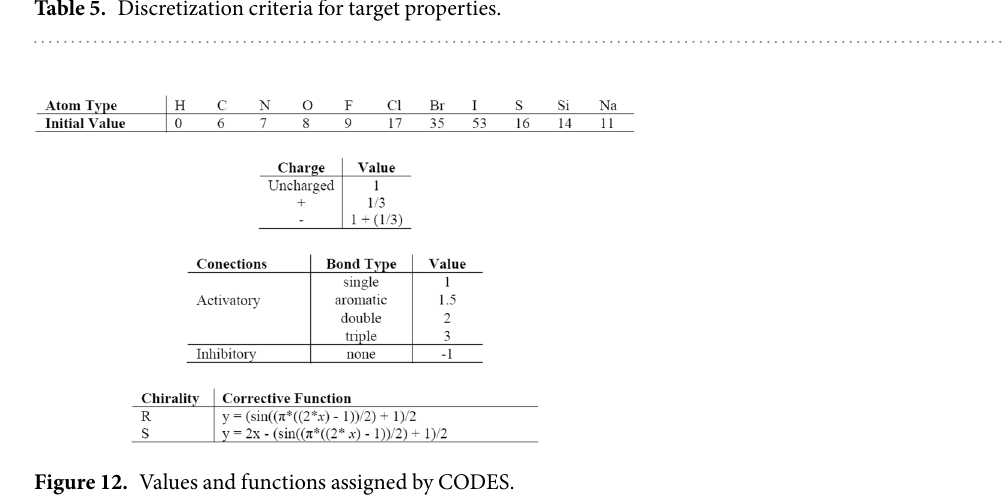
Figure 12. Values and functions assigned by